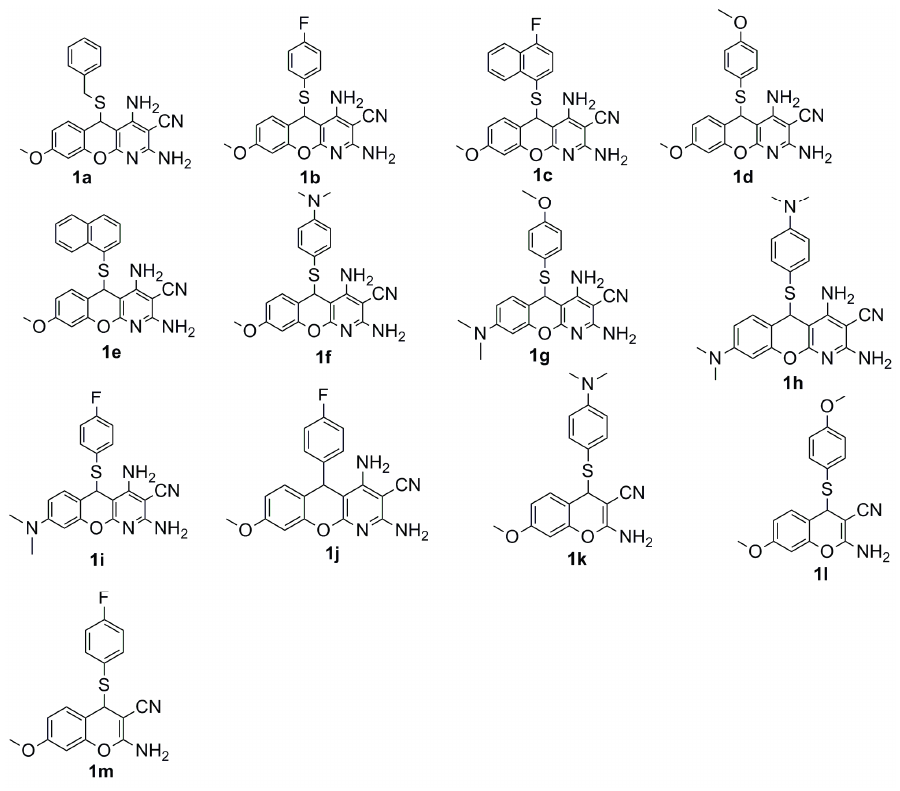
Figure 3. Synthesized chromenopyridines and